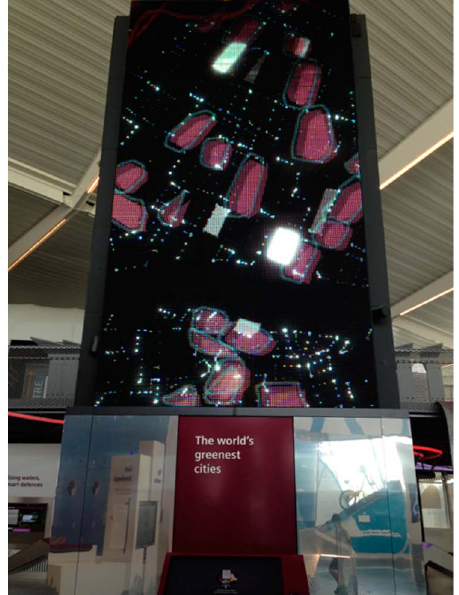
The City Icon digital sculpture, located in the Creating Cities subzone of The Crystal’s Future of Cities exhibition (Source: author,